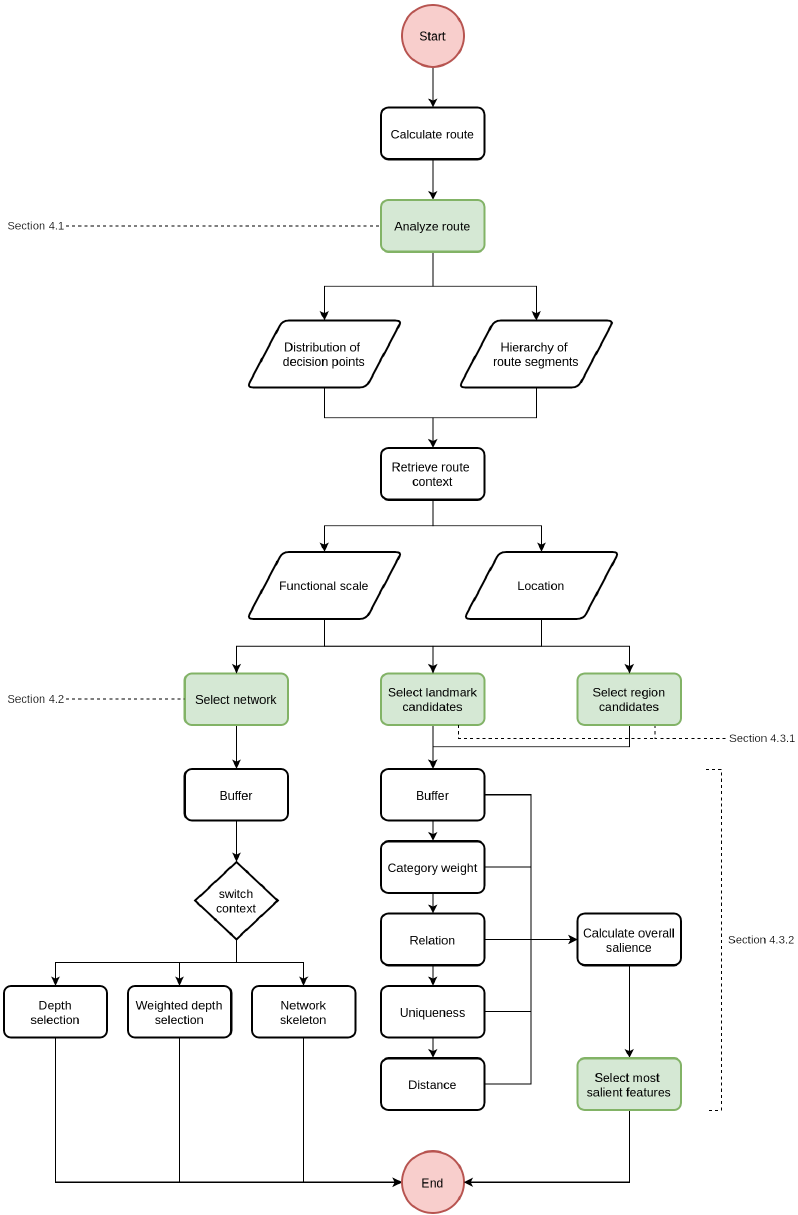
Figure 1: Flowchart of the algorithm. For the description see introduction of Section 4. For details on the separate steps see the respective